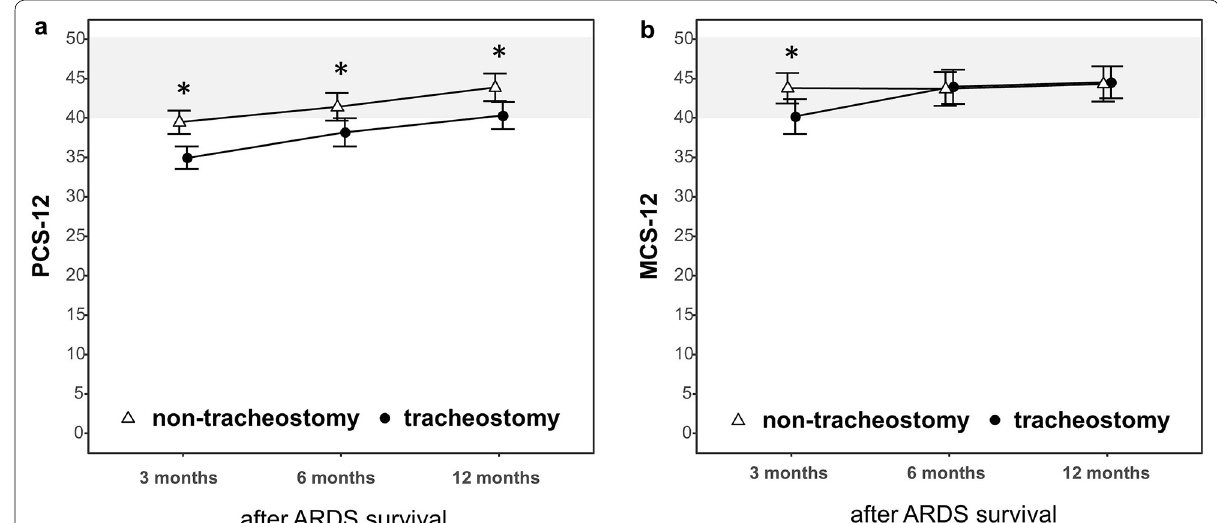
Fig. 2 Univariate analysis of Short Form‑12 (SF‑12) self‑report response of ARDS survivors across follow‑up time points (* p < 0.05; means